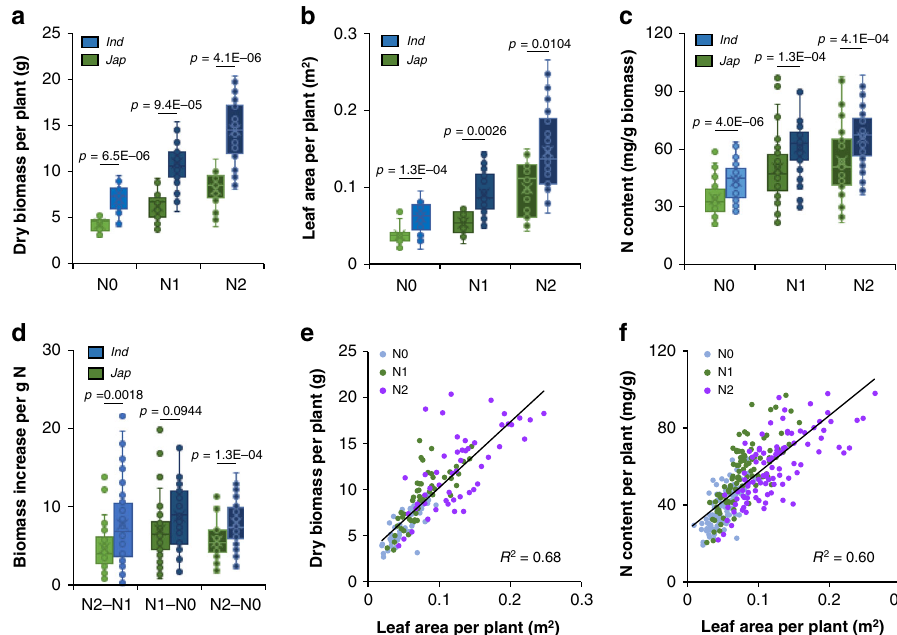
Fig. 1 Indica and japonica subspecies show varied biomass accumulation and nitrogen-use divergence. a – c Boxplots of the mean amount of dry biomass, leaf area, and total N content of indica ( Ind ) and japonica ( Jap ) accessions growing under different nitrogen supply at the tillering stage. d Boxplot of the mean increment of biomass for each unit of added nitrogen fertilizer of indica ( Ind ) and japonica ( Jap ) accessions growing under different nitrogen supply at the tillering stage. The mean values in ( a – d ) were obtained from nine individual plants of each accession. Box bounds represent the 25th and 75th percentile, center line represents the median, × indicates the mean, and whiskers represent the 25th percentile − 1.5 * the interquartile range and the 75th percentile + 1.5 * the interquartile range. Statistical signi fi cance was calculated with two-tailed Welch ’ s unpaired t -test and p values are indicated. e , f Correlation analysis of leaf area with dry biomass ( e ) and with N content ( f ) based on the data shown in ( a – c ). N0, N1, and N2 in this fi gure indicate 0, 96, and 192 (kg/ha) of N, separately. Source data are provided as a Source Data fi